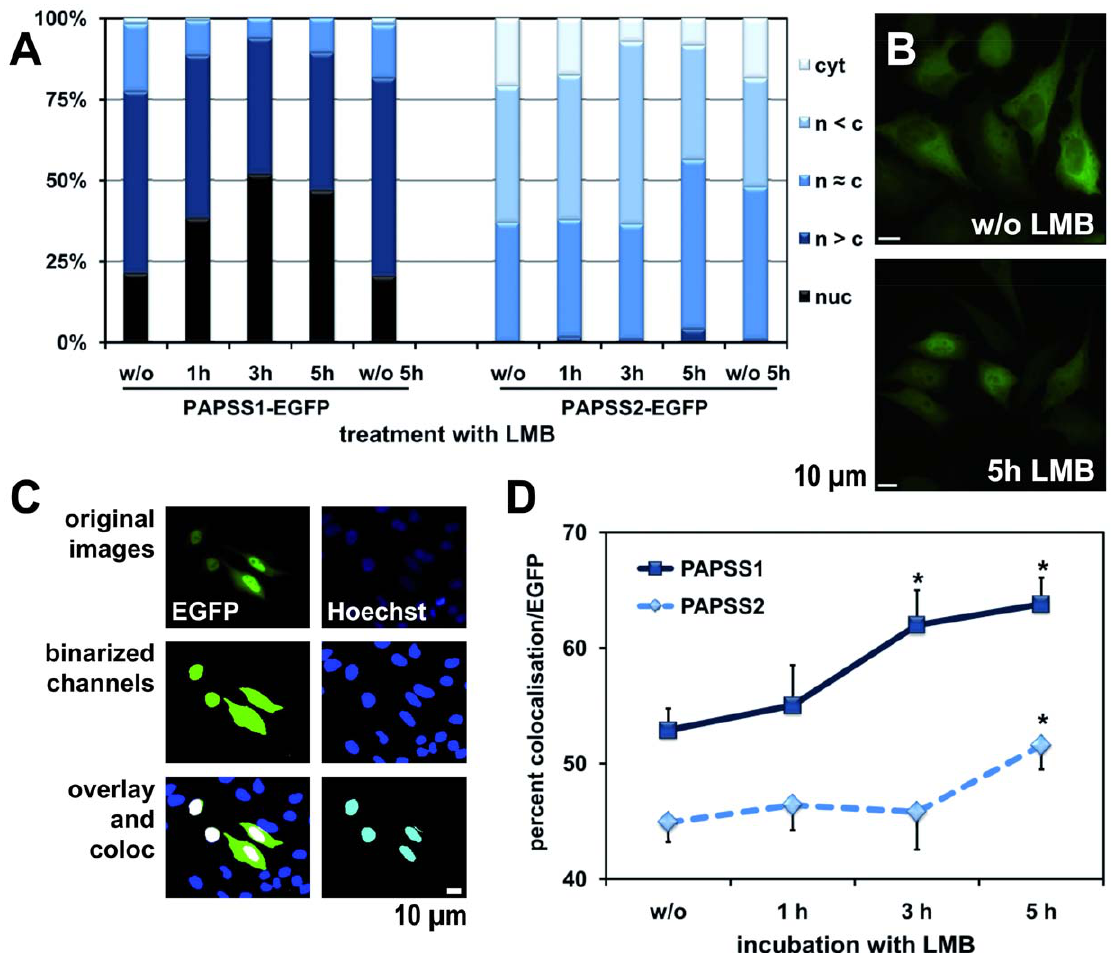
Figure 3. Effect of LMB treatment on PAPS synthase localisation. A , localisation patterns for PAPS synthase wild-type fusion proteins following LMB treatment. HeLa cells expressing PAPSS1- and PAPSS2-EGFP fusion proteins were treated with the export inhibitor leptomycin B (LMB) at a concentration of 10 nM for prolonged periods of time. At least 200 cells were visually evaluated per lane according to the scheme from figure 1. B , examples of PAPSS1-EGFP expressing HeLa cells after 5 h LMB or mock treatment demonstrating increased nuclear accumulation caused by LMB. C , alternative assessment of quantitative localisation after binarisation. Original images are shown before and after binarisation. In this instance, the extracted parameters were: area of Hoechst fluorescence (16%), EGFP fluorescence (8.5%) and co-localisation (3.8%), co-localisation relative to Hoechst (23%) and EGFP (44%) areas (Coloc rel H and Coloc rel E, respectively) as well as the ratio of EGFP and Hoechst areas (0.53) reflecting transformation efficiency. The area of Coloc rel E was found to be the most robust parameter for nuclear localisation of our PAPS synthase-EGFP fusion proteins. D , effect of LMB treatment on PAPS synthase-EGFP fusion protein localisation measured according to C . The area of Coloc rel E significantly increases for both PAPSS1- and PAPSS2-EGFP proteins upon prolonged LMB treatment. *p values for unpaired two-tailed t-test relative to no LMB treatment: PAPSS1-EGFP with 3 h LMB (0.034) and 5 h LMB (0.006) as well as for PAPSS2B-EGFP with 5 h LMB treatment (0.038).